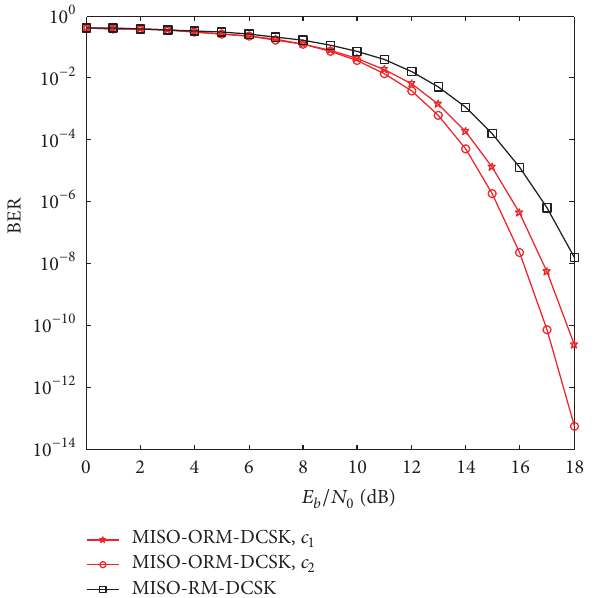
Figure 5: Each BER in the AWGN channelfor MISO-ORM-DCSK.